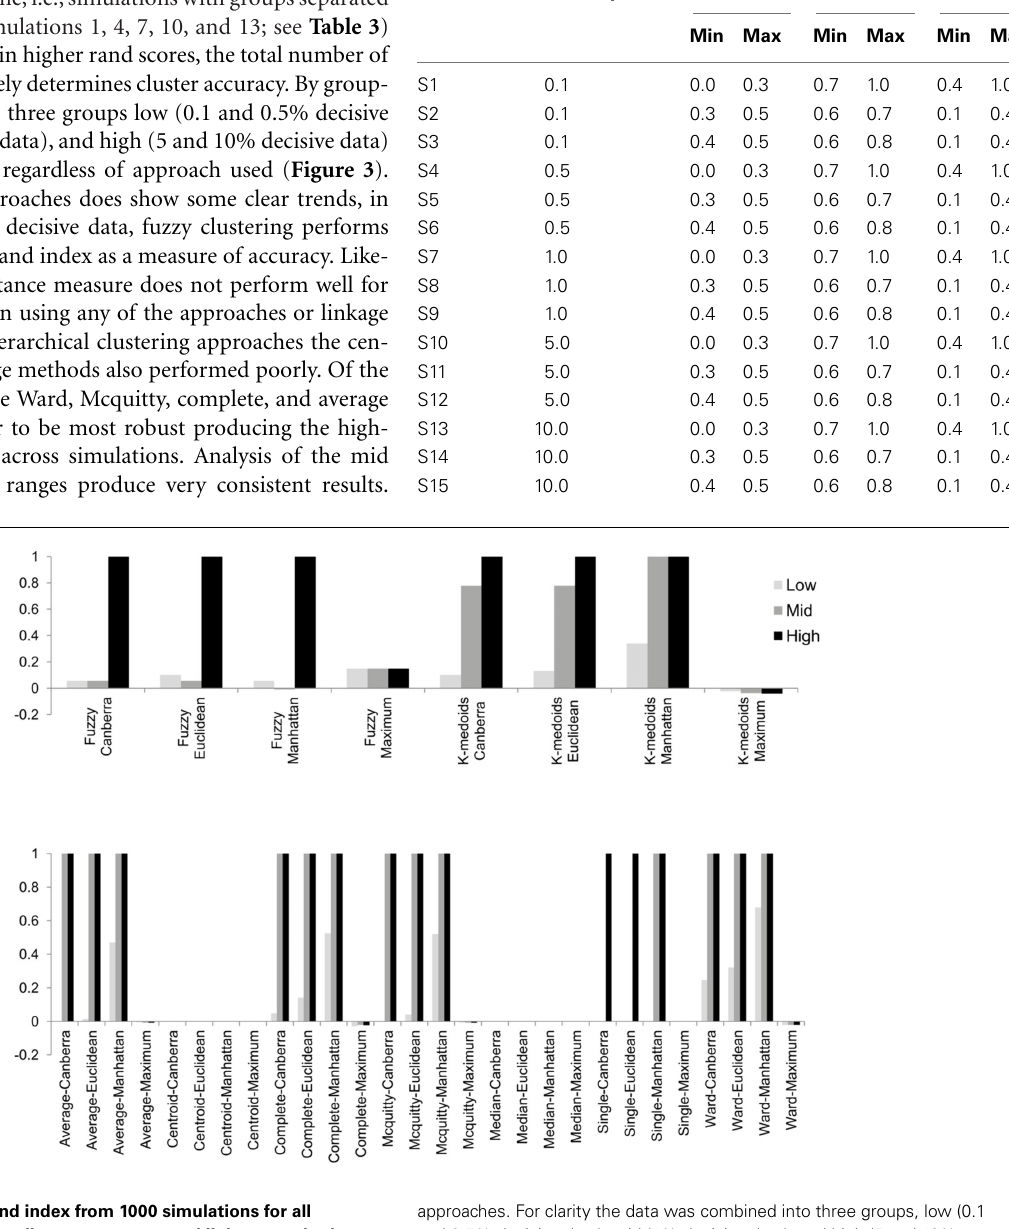
FIGURE 3 |The median rand index from 1000 simulations for all combinations of clustering, distance measure and linkage method used. (A) Fuzzy and k -medoids approaches, (B) hierarchical clustering